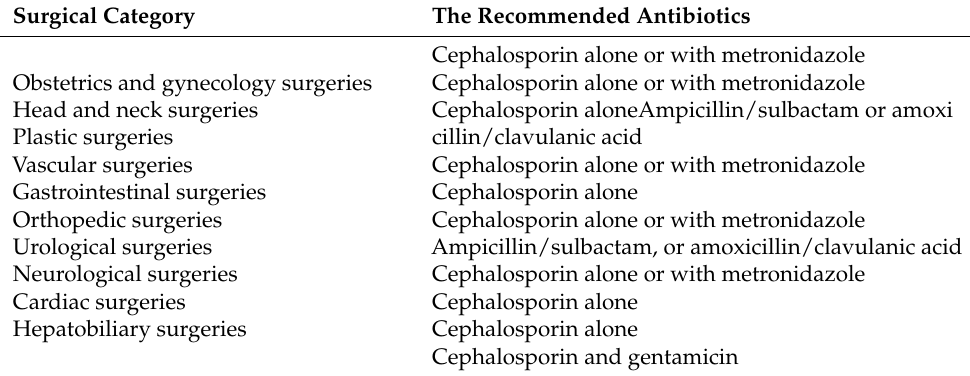
Table 5. The recommended prophylactic antibiotics for different surgical categories.